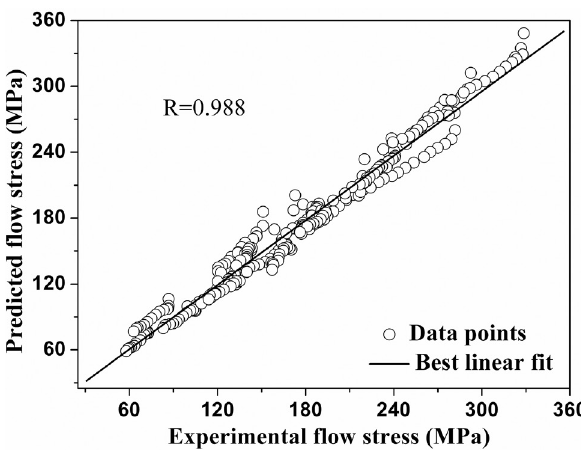
Fig. 8: Correlation between the experimental and predicted flow stress from the developed constitutive